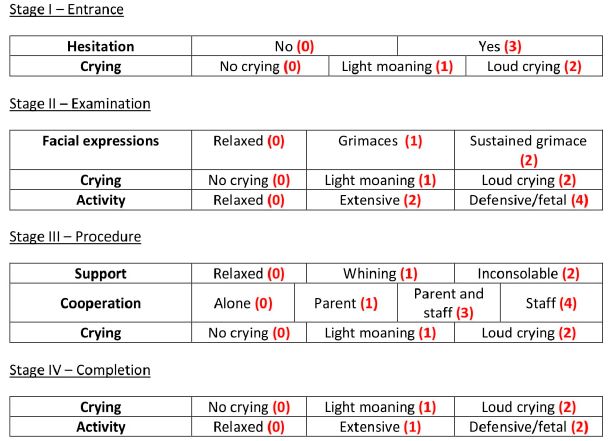
Figure 1. The weights of parameters considered in VACS.